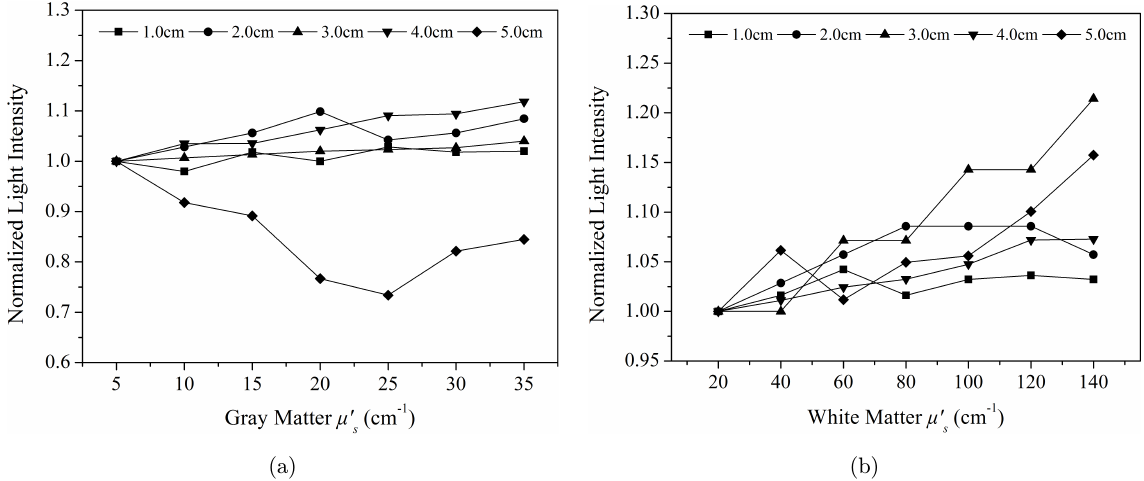
Fig. 7. Normalized light intensity with (cid:1) 0 s of brain substance. (a) Curves of the light intensity and (cid:1) 0 s of gray matter and (b) curves of the light intensity and (cid:1) 0 s of white